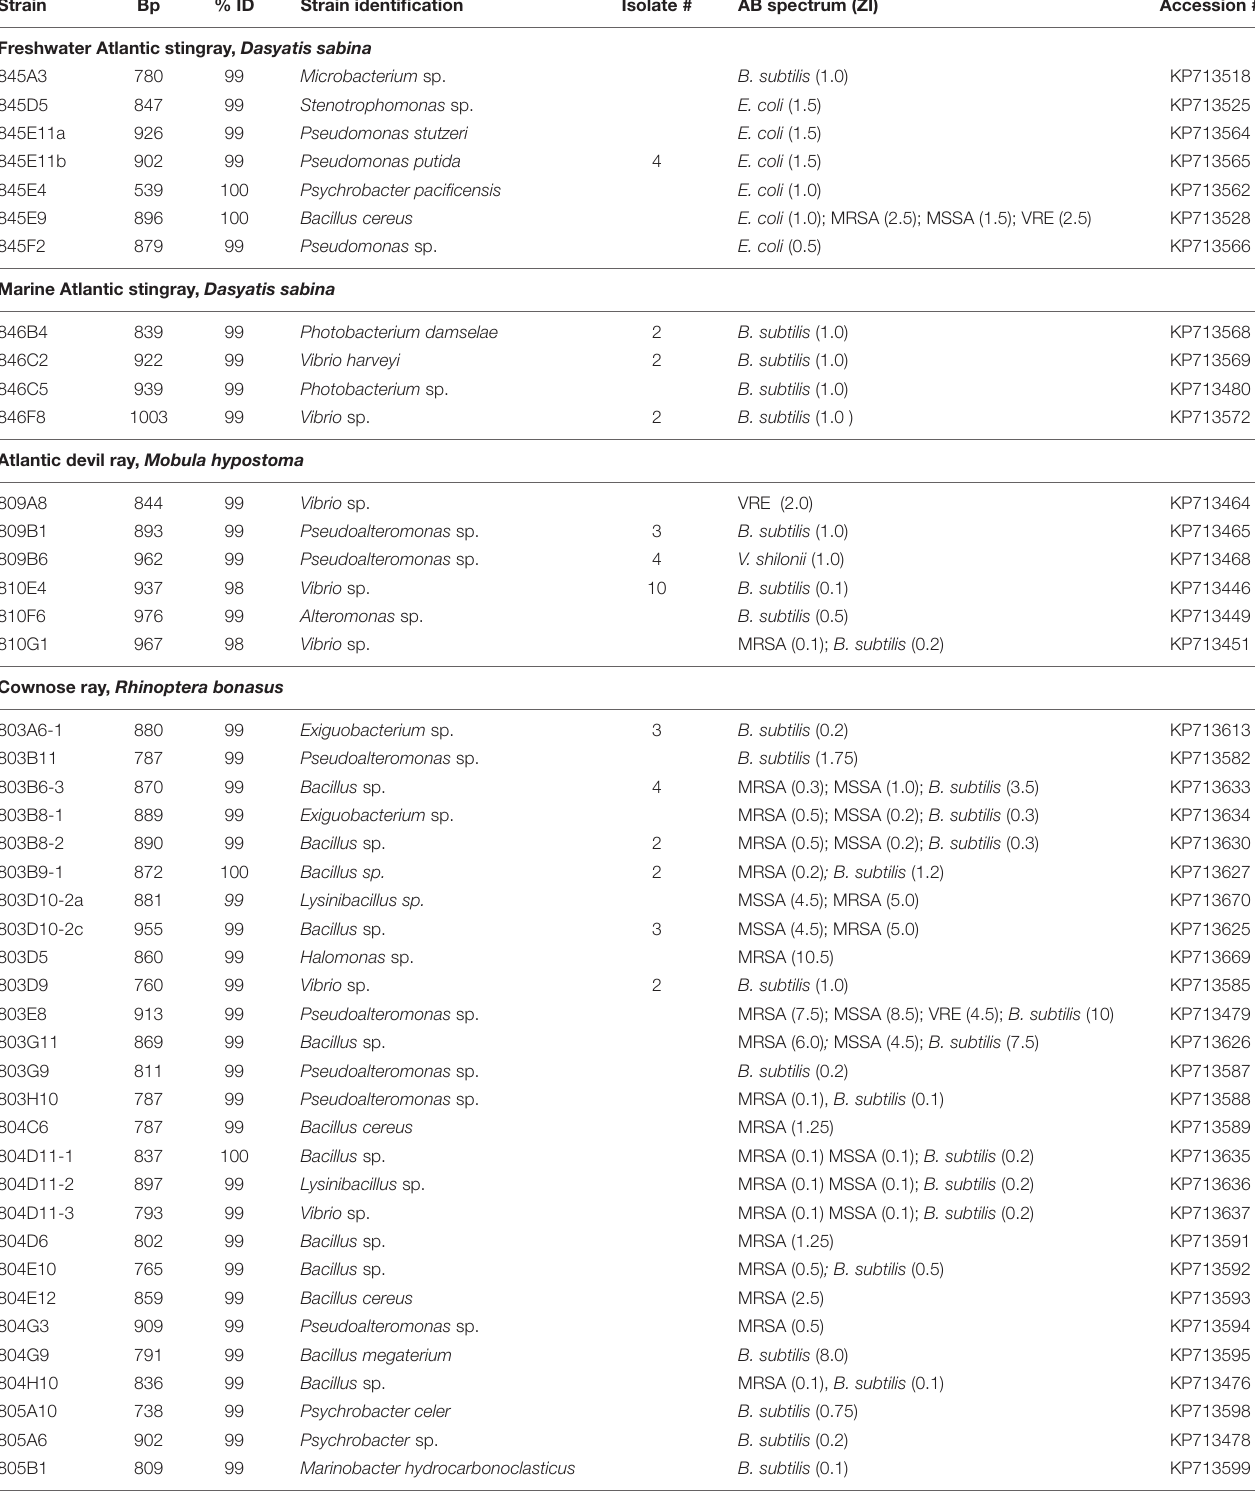
TABLE 2 | List of representative bacteria isolated from the mucus of rays. Strain Bp Isolate